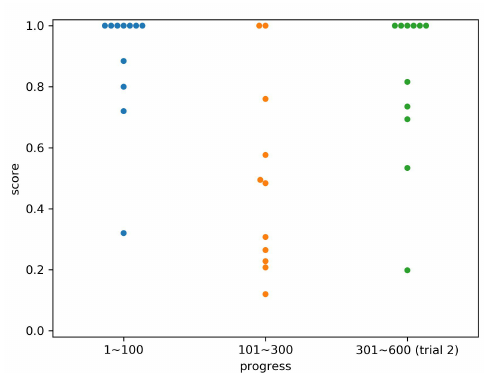
Figure 13. Scores of Subject 3 by time period.